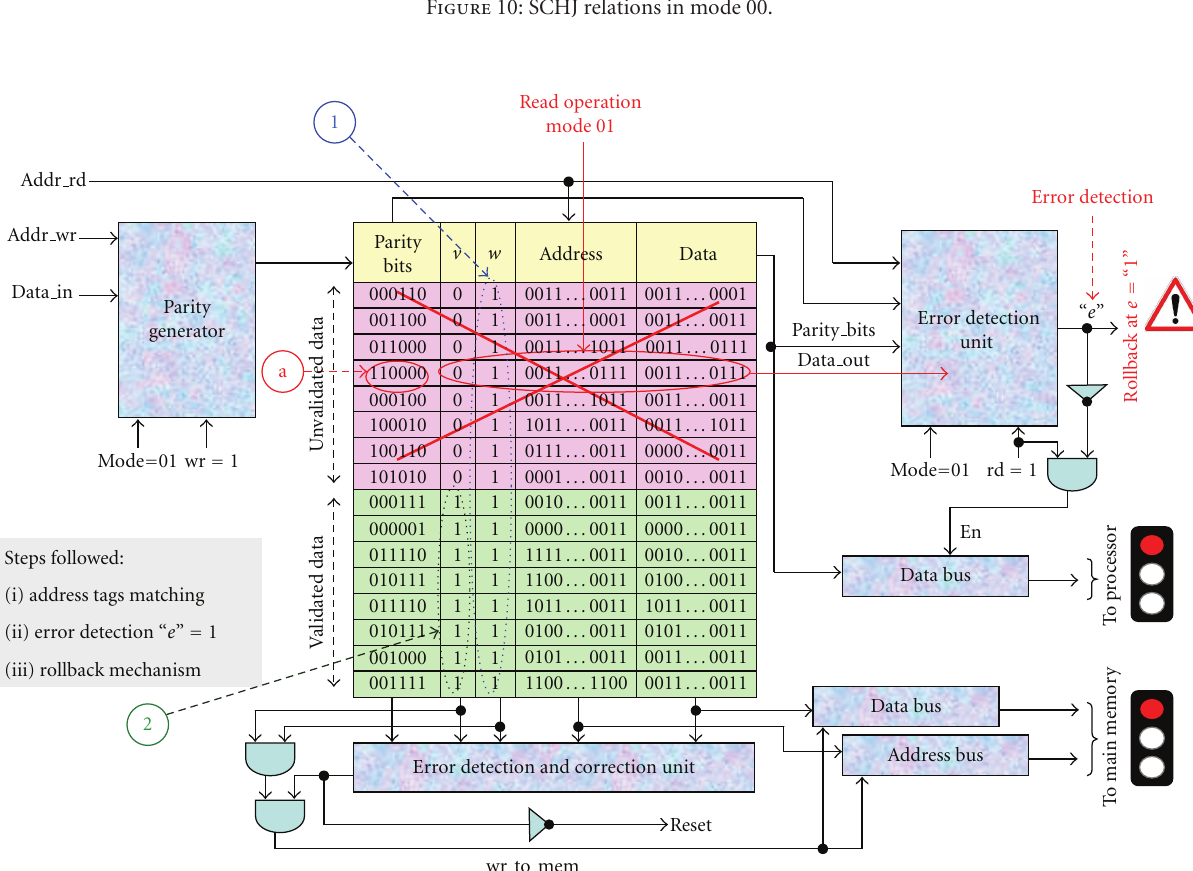
Figure 11: Reading UVD from SCHJ in mode 01.